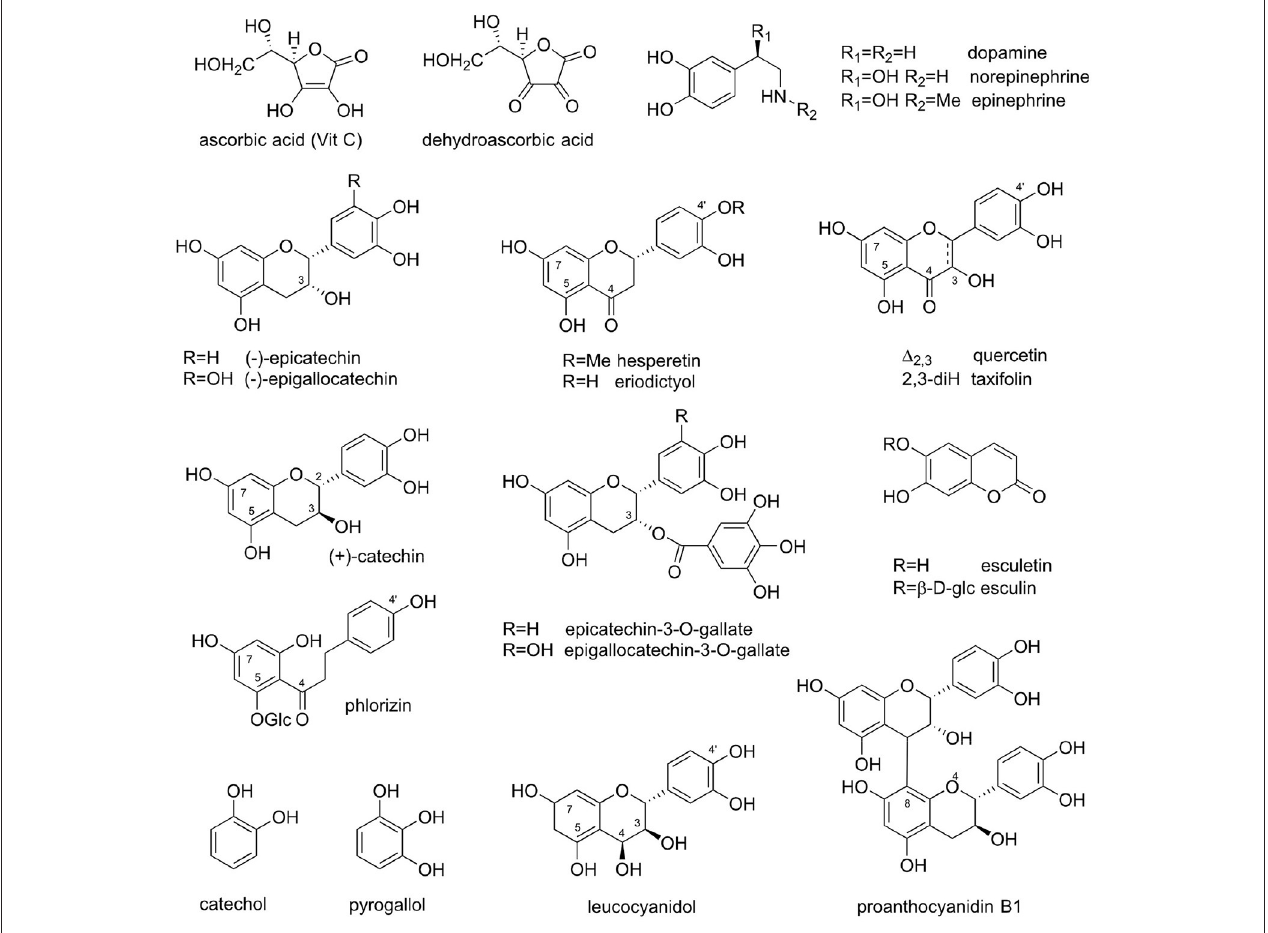
FIGURE 1 | Natural products featured in the Vitamin P story: Vitamin C (ascorbic acid); dehydroascorbate; dopamine, noradrenaline (norepinephrine), and adrenaline (epinephrine); hesperetin and eriodictyol; (–)-epicatechin and (–)-epigallocatechin; quercetin and taxifolin; ( + )-catechin; (–)-epicatechin-3- O -gallate and (–)-epigallocatechin-3- O -gallate (EGCG); esculetin and esculin; phlorizin; catechol; pyrogallol; leucocyanidol; and proanthocyanidin B1 [epicatechin-(4 β →